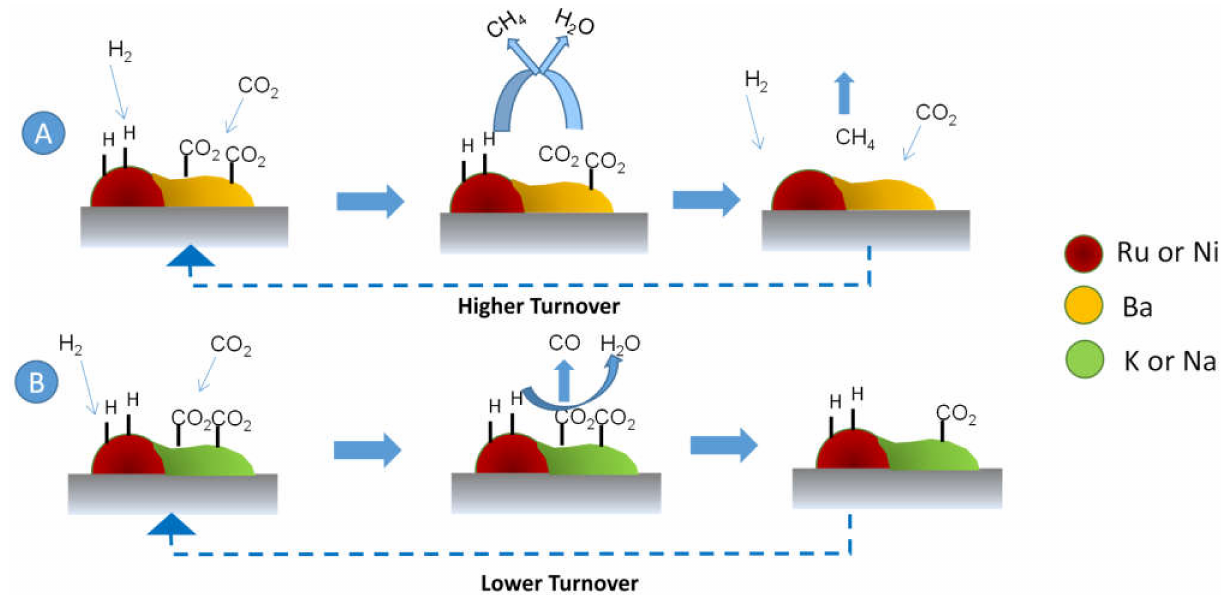
Figure 10. Schematic representation of the reaction